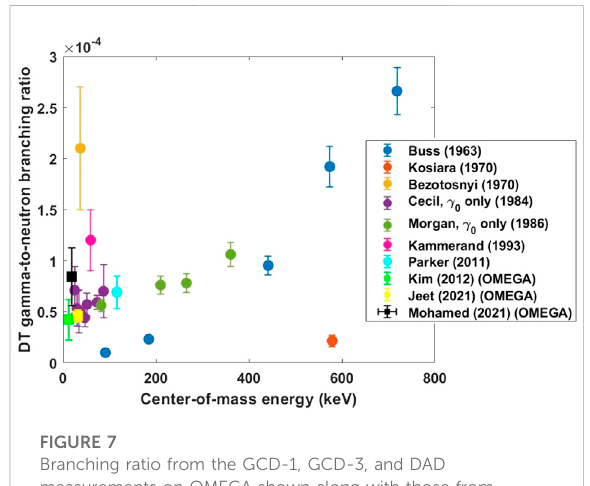
FIGURE 7 Branching ratio from the GCD-1, GCD-3, and DAD measurements on OMEGA shown along with those from accelerator experiments discussed in Refs. 25 – 32. FIGURE 8